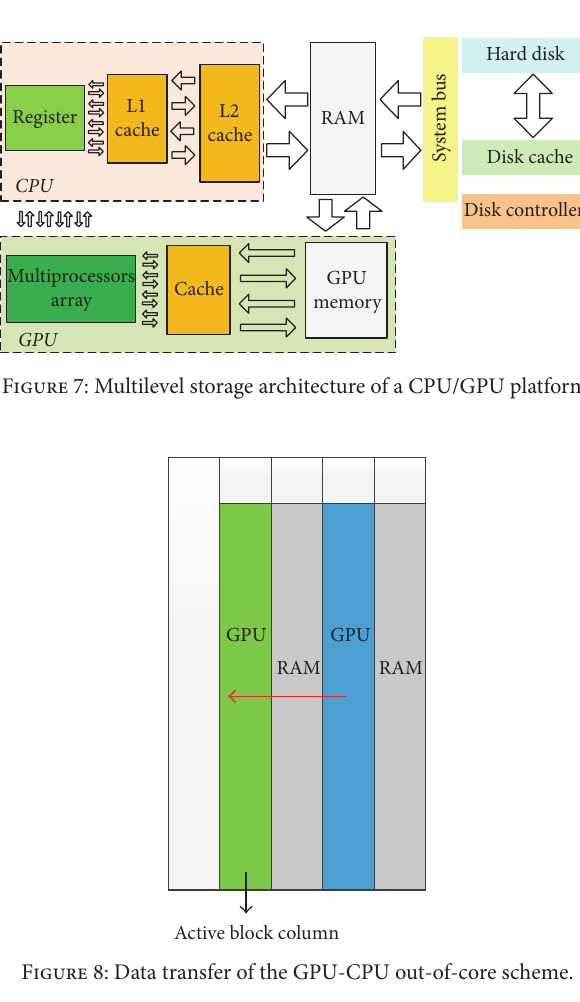
cores and one GPU card. The context technique is used to partition one GPU card into two virtual GPU cards. And one MPI process is assigned to one CPU core and one virtual